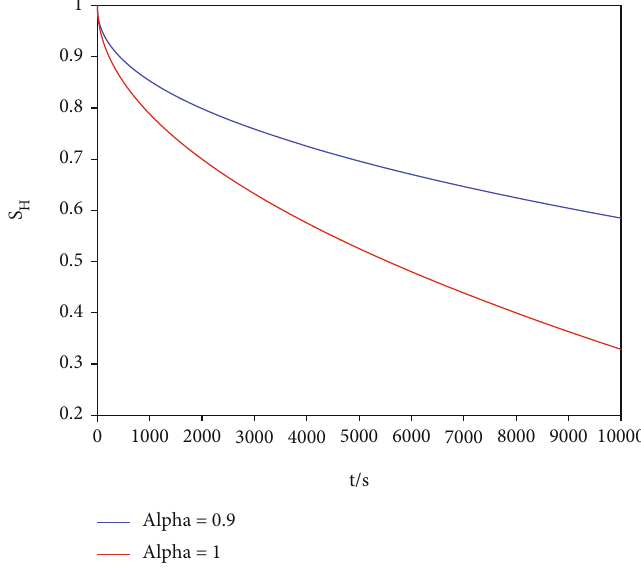
Figure 7: The variation of hydrate saturation with time.